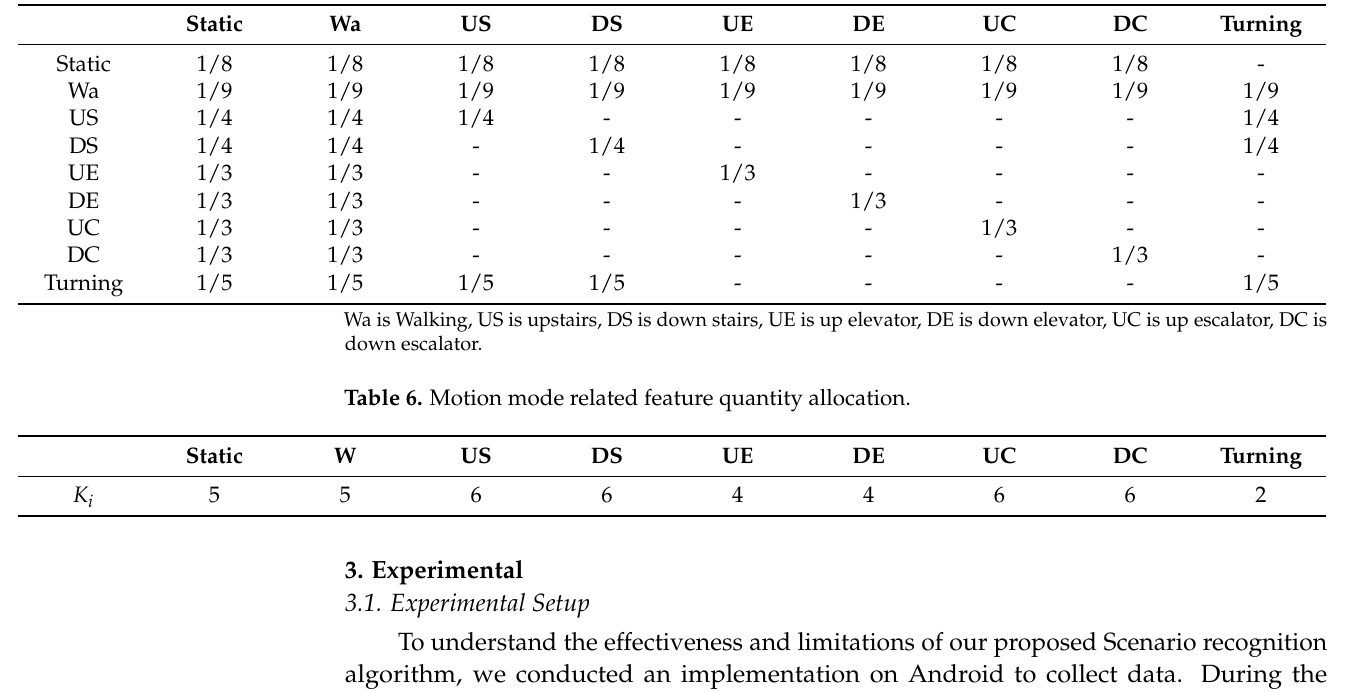
Table 5. Motion mode transition probability allocation.